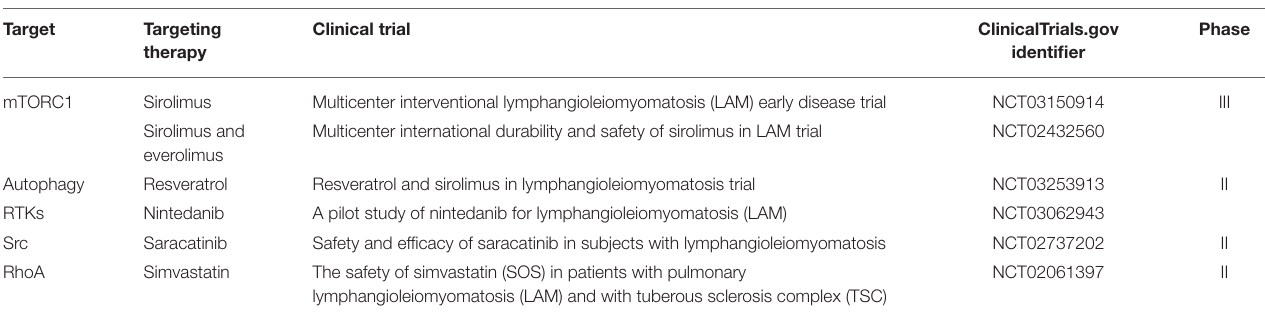
TABLE 1 | Current clinical trials studying potential targets for